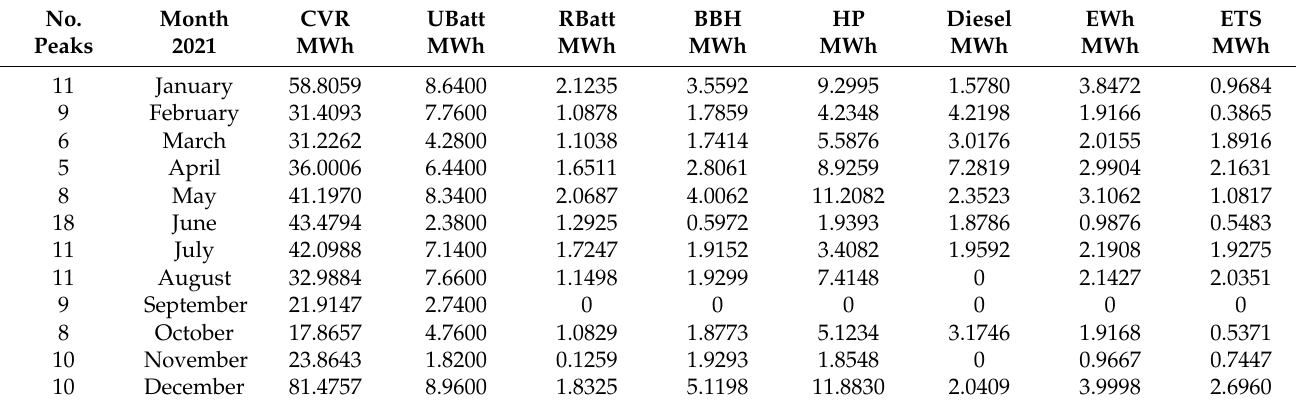
Table 4. Contributions of EERs for monthly peak load shaving.